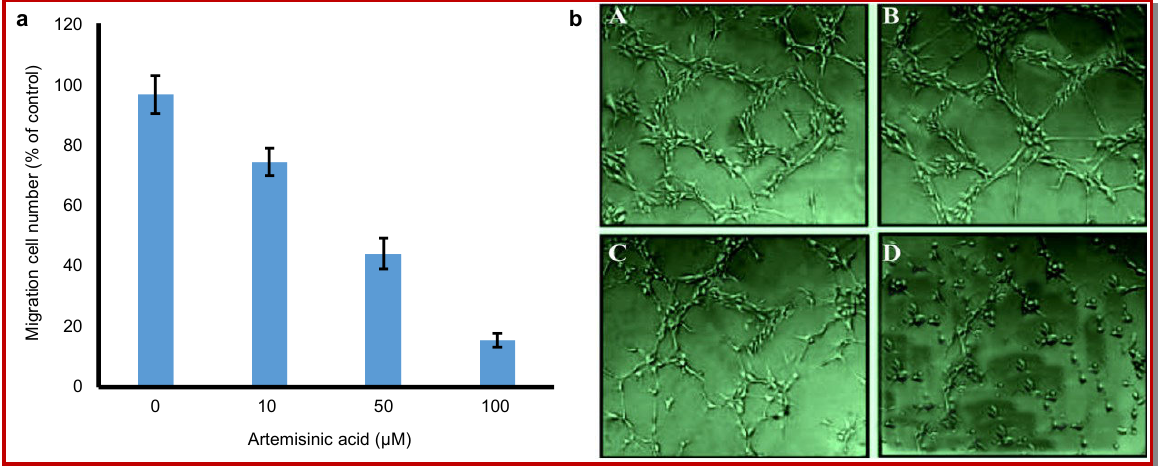
Figure 3: a) Effects of artemisinic acid on the migration of cells. The cells were treated with increasing doses of artemisinic acid (0, 10, 50 and 100 µM). b) Effects of artemisinic acid on capillary structure generation of endothelial cells. The cells were treated with 0 (A), 10 (B), 50 (C) and 100 (D) µM dose of artemisinic acid respectively